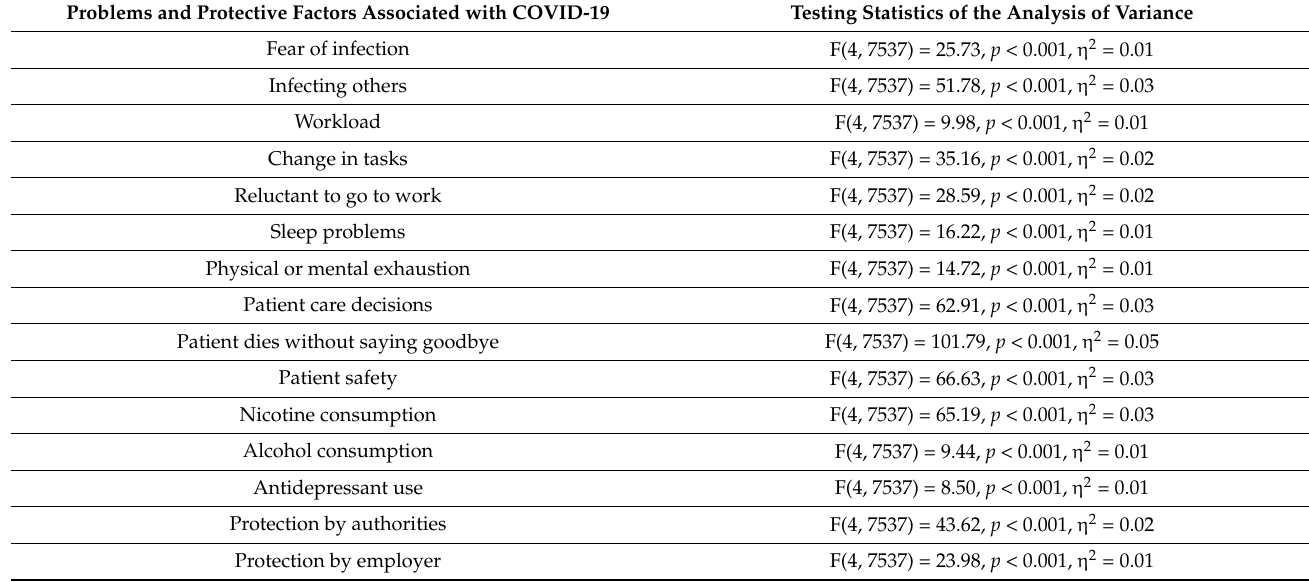
Table 4. Analysis of variance on different COVID-19-associated problems and protective